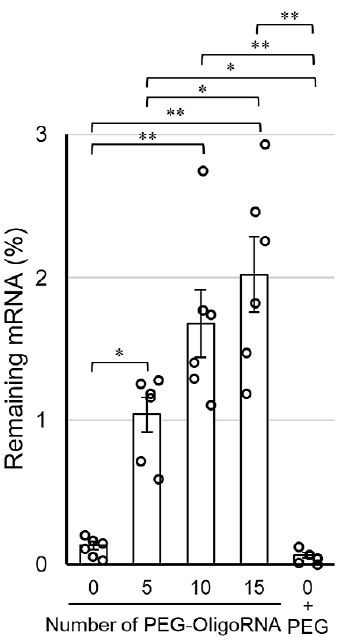
Figure 4. Remaining amount of mRNA after incubation in 1% FBS solution for 15 min. Data are shown as average mean ± SEM. Each dot refers to an individual measurement ( n = 6). Statistical difference was analyzed by ANOVA followed by Tukey’s test. Abbr., 0 + PEG: 0 *PEG-mRNA in the presence of free PEG strands. * p < 0.05, ** p < 0.01.